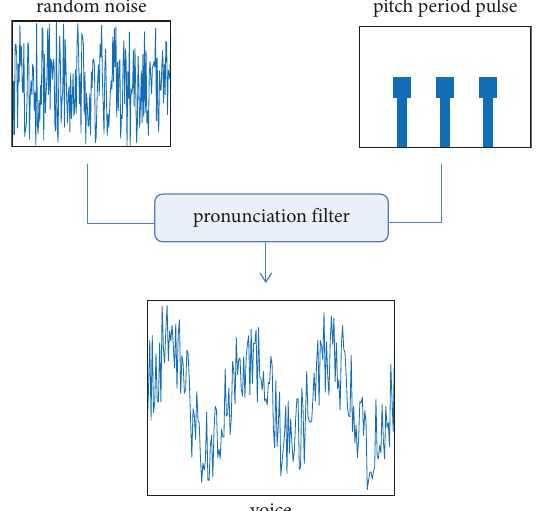
Figure 2: Mathematical expression of the pronunciation process.